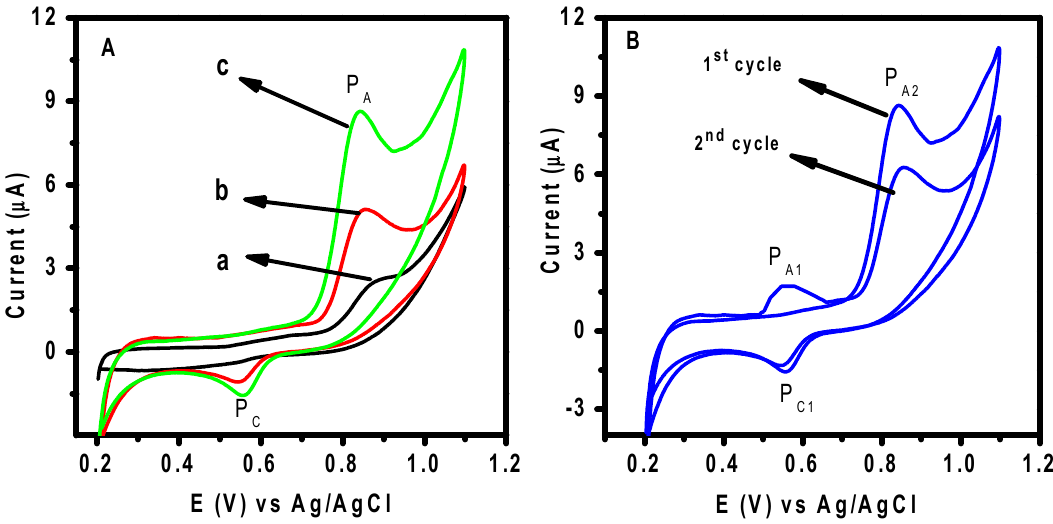
Figure 6. ( A ) CVs of 0.5 µ M of DIC in 0.1 M of BR buffer (pH 3.0) at a scan rate 50 mV/s (a) Figure 6. ( A ) CVs of 0.5 µM of DIC in 0.1 M of BR buffer (pH 3.0) at a scan rate 50 mV/s (a) unmod- Figure 6. ( A ) CVs of 0.5 µM of DIC in 0.1 M of BR buffer (pH 3.0) at a scan rate 50 mV/s (a) unmod- ified CPE, (b) Chs NPs/CPE, and (c) M-Chs NC/CPE. ( B ) Two continuous cyclic voltametric scans unmodified CPE, (b) Chs NPs/CPE, and (c) M-Chs NC/CPE. ( B ) Two continuous cyclic voltametric ified CPE, (b) Chs NPs/CPE, and (c) M-Chs NC/CPE. ( B ) Two continuous cyclic voltametric scans of 0.5 µM of DIC solution in 0.1 BR buffer (pH 3.0) at scan rate 50 mV/s at M-Chs NC/CPE. of 0.5 µM of DIC solution in 0.1 BR buffer (pH 3.0) at scan rate 50 mV/s at M-Chs NC/CPE. scans of 0.5 µ M of DIC solution in 0.1 BR buffer (pH 3.0) at scan rate 50 mV/s at M-Chs NC/CPE. Figure 6. ( A ) CVs of 0.5 µM of DIC in 0.1 M of BR buffer (pH 3.0) at a scan rate 50 mV/s (a) unmod- ified CPE, (b) Chs NPs/CPE, and (c) M-Chs NC/CPE. ( B ) Two continuous cyclic voltametric scans Figure 6. ( A ) CVs of 0.5 µM of DIC in 0.1 M of BR buffer (pH 3.0) at a scan rate 50 mV/s (a) unmod- of 0.5 µM of DIC solution in 0.1 BR buffer (pH 3.0) at scan rate 50 mV/s at M-Chs NC/CPE. ified CPE, (b) Chs NPs/CPE, and (c) M-Chs NC/CPE. ( B ) Two continuous cyclic voltametric scans of 0.5 µM of DIC solution in 0.1 BR buffer (pH 3.0) at scan rate 50 mV/s at M-Chs NC/CPE.